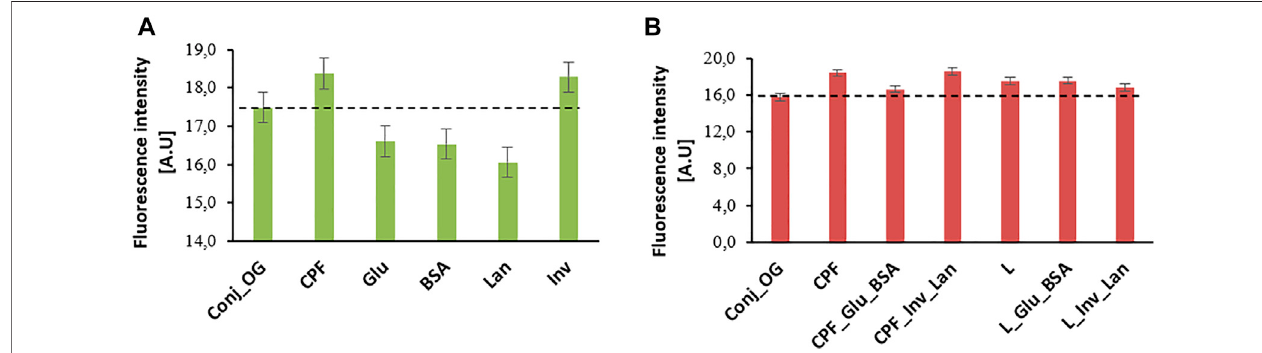
Frontiers in Environmental Science |